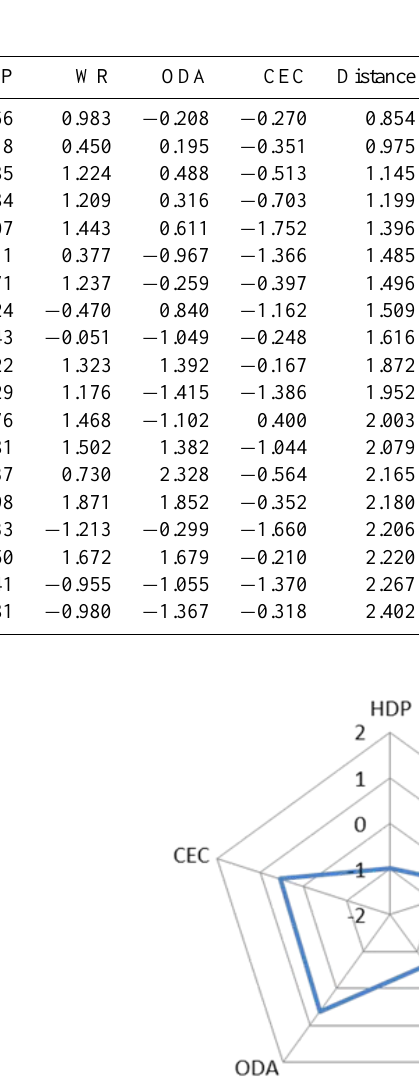
Table 9. Factors loadings and distances to average for profile 3. The last 5 countries in the list are considered outliers of the cluster, showing divergences with the average value of the profile.